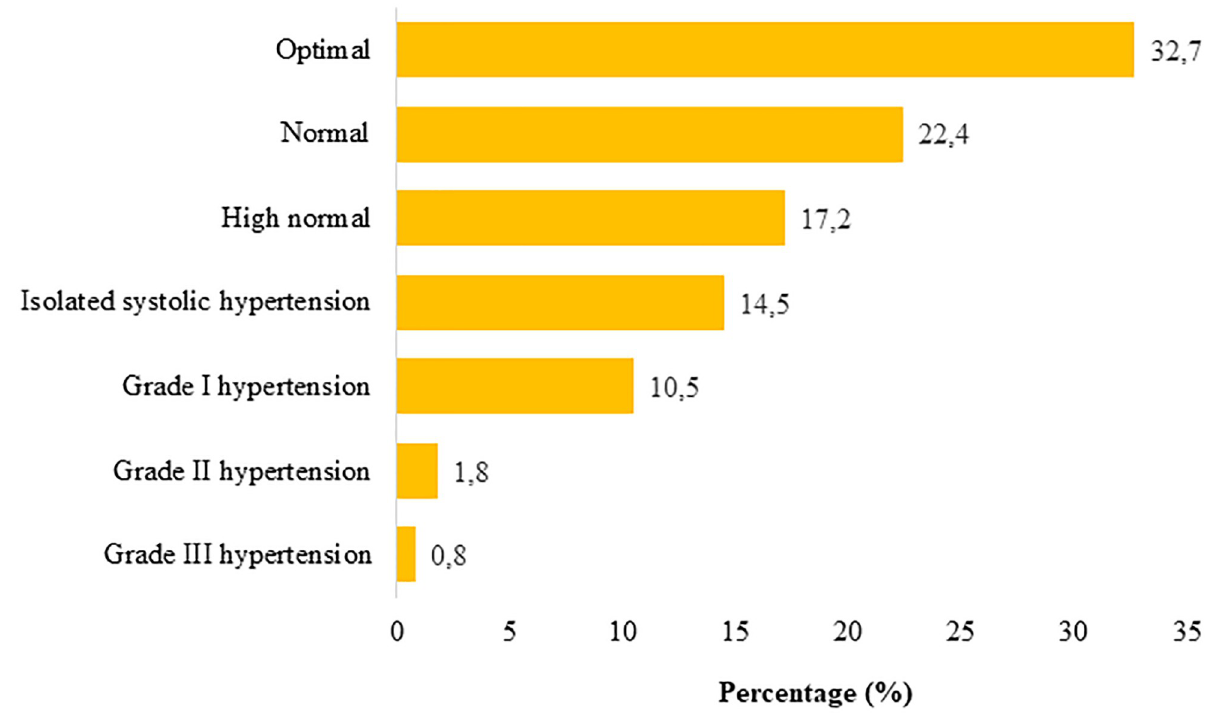
Fig 1. Blood pressure classification among migrants, Oujda, Morocco,